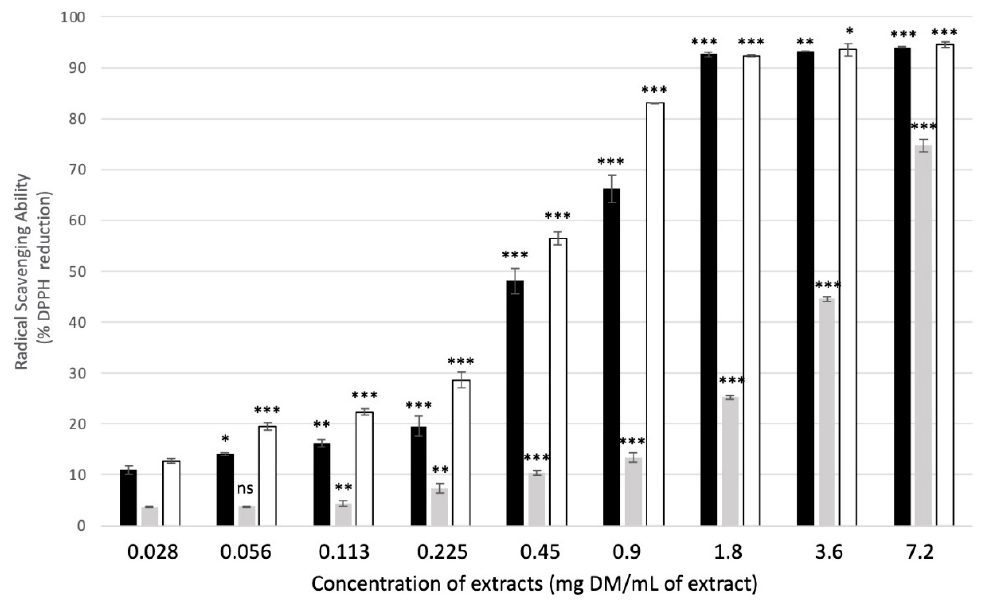
Figure 4. Radical scavenging ability (RSA) of the three plant extracts under study expressed in percentage of DPPH reduced: mate: black bars, rosemary: grey bars, green tea: white bars. Shown are the means of six replicates +/ − SD. Significant differences between different concentrations of the same plant extract are indicated by * for p -value< 0.05, ** for p -value < 0.01, and *** for p -value < 0.001. ns: not significant